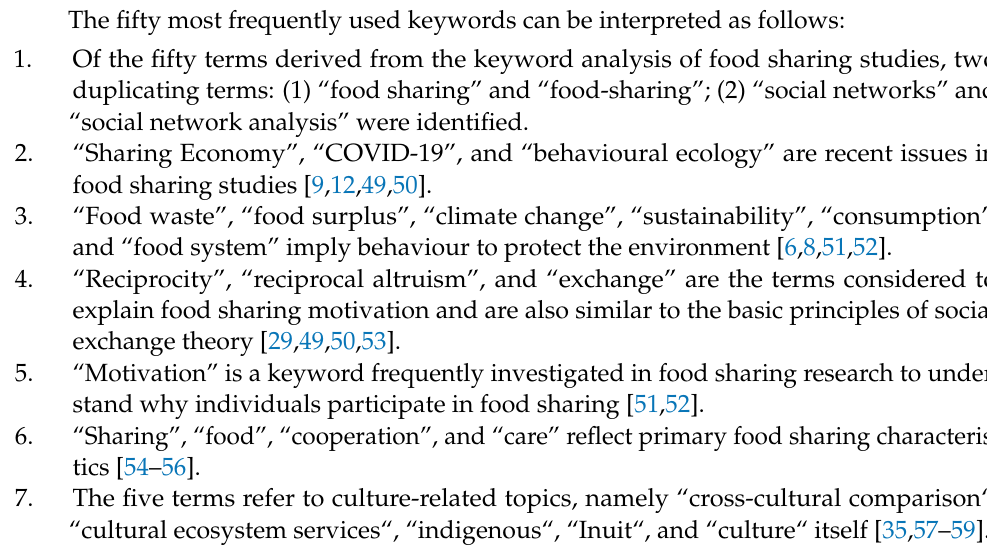
Figure 2. The food sharing